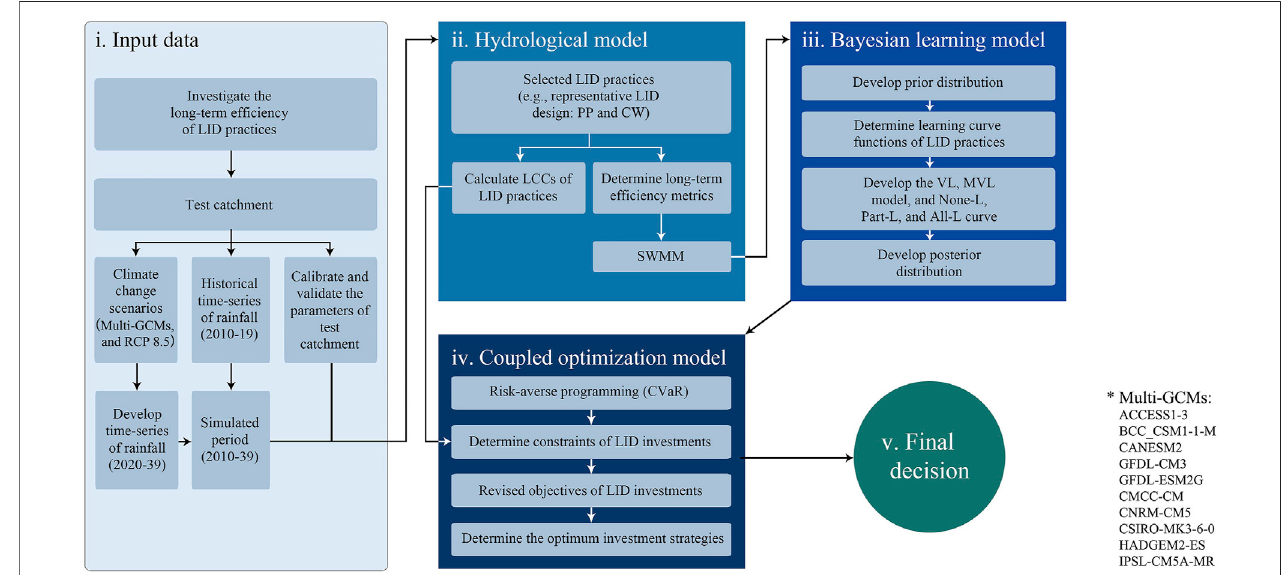
FIGURE 1 | Flowchart of the methodology for the coupled Bayesian optimization model of LID investments. Note: PP, permeable pavement; CW, constructed wetland; LCC, life cycle cost; SWMM, Storm Water Management Model; VL, variance learning; MVL, mean-variance learning; None-L, none learning; Part-L, part learning; All-L, all learning; CVaR, conditional value at risk.